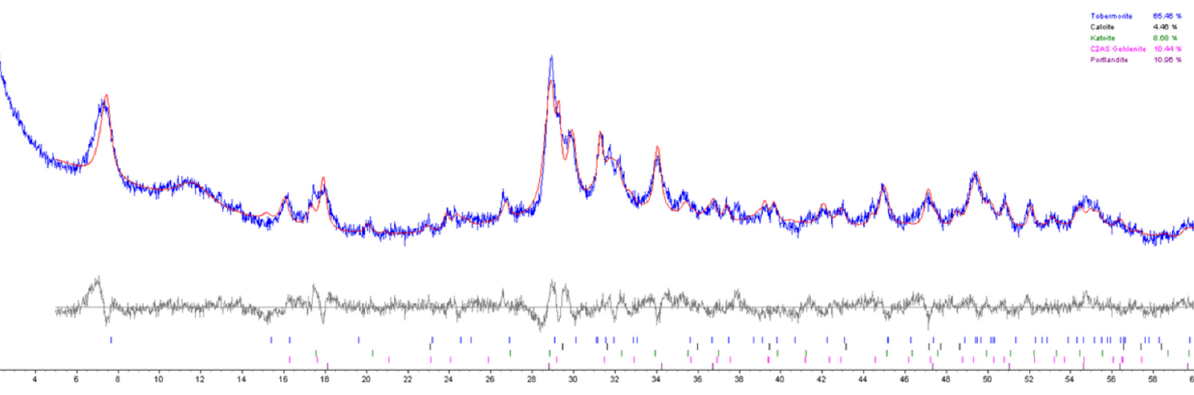
Figure A2. XRD pattern, calculated pattern, and residual for TOB-2.